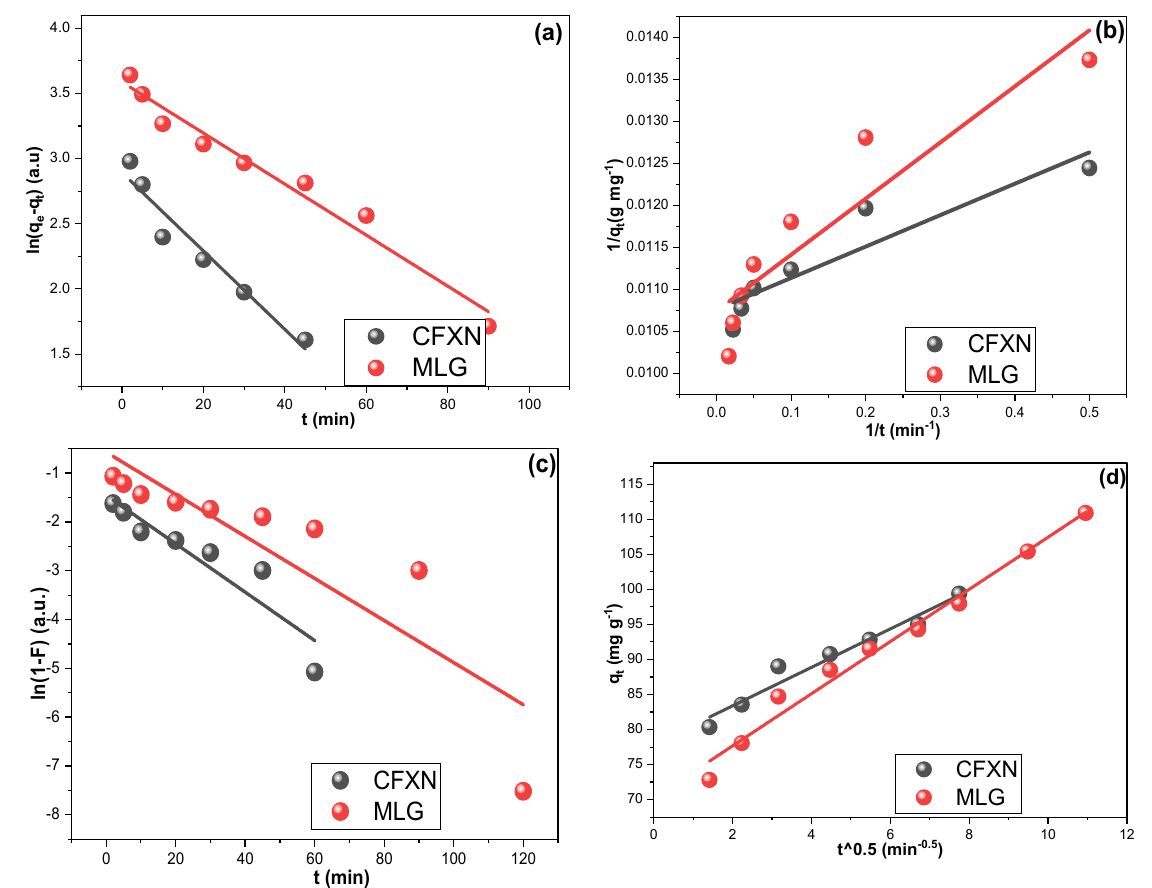
Figure 5. ( a , b ) present the adsorption rate order plots for PSFO and PSSO models for the adsorption of CFXN and MLG on the fabricated CNPs from 50.0 mg L − 1 at 25 ◦ C; ( c , d ) present the rate control mechanism investigations using LFDM and IPDM for CFXN and MLG adsorption on the fabricated CNPs from 50.0 mg L − 1 at 25 ◦ C. Figure 5c,d present the LFDM and IPDM investigations for CFXN and MLG